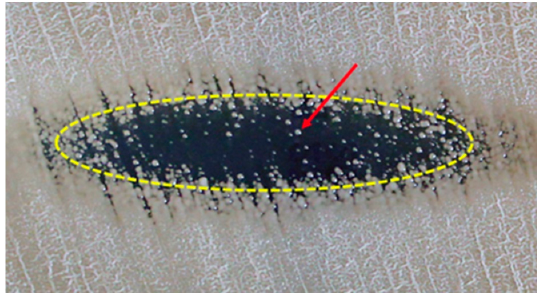
Figure 1. The growth inhibition zone induced by plasma that was generated by the linear Figure1. Thegrowthinhibitionzone inducedbyplasmathat wasgeneratedbythe linearmicrodischarge microdischarge jet. The red arrow indicates one of the spot colonies, which grew after plasma jet. The red arrow indicates one of the spot colonies, which grew after plasma treatment.